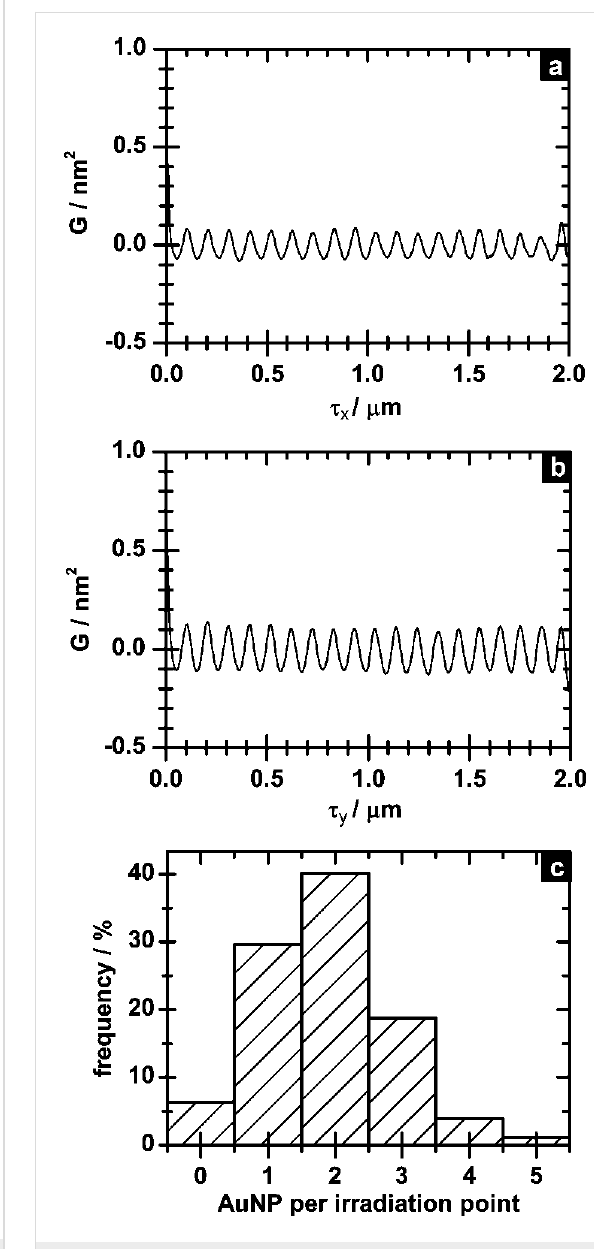
Figure 8: Horizontal (a) and vertical (b) spatial autocorrelation of AFM height measurement in Figure 7b and histogram of the number of AuNPs per irradiation spot